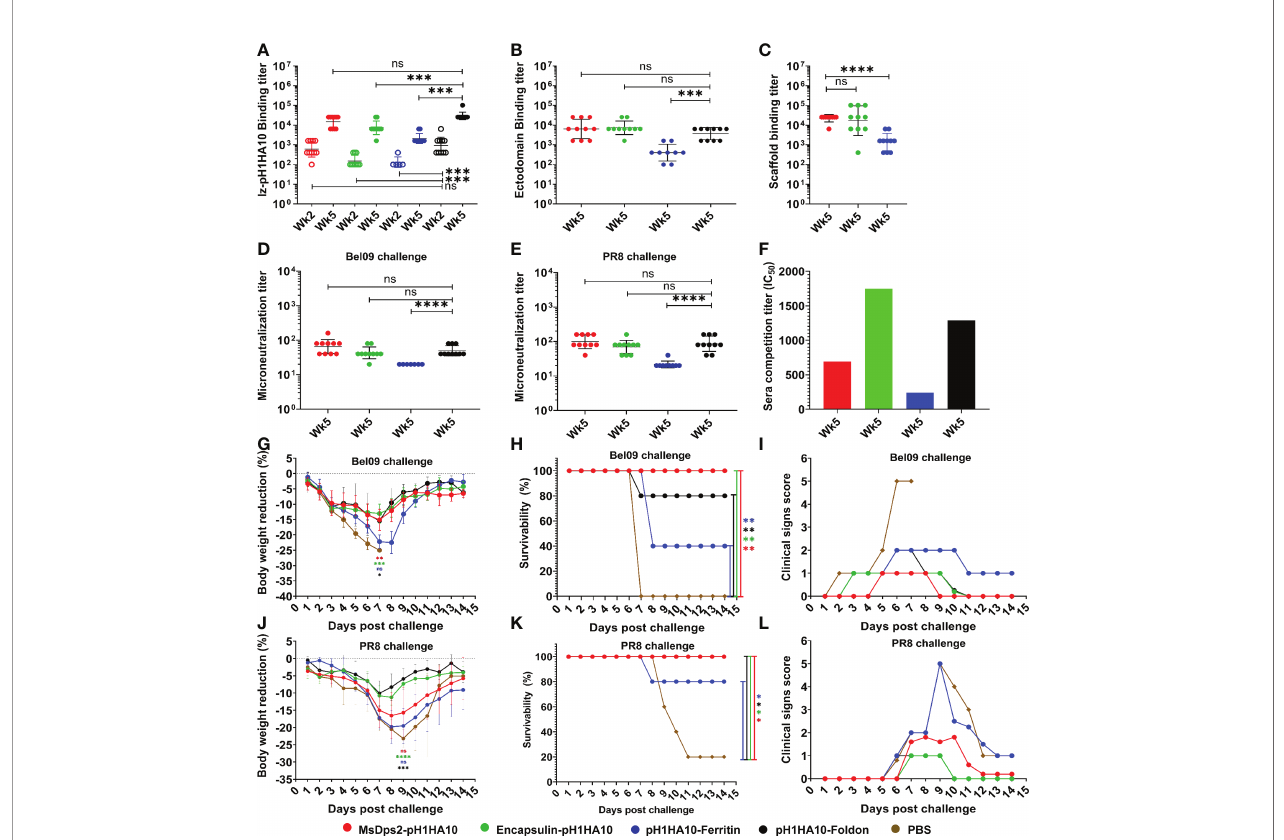
FIGURE 5 | Mice immunization and challenge studies. Mice (n=5) were intramuscularly immunized with stem-nanoparticle immunogens- MsDps2-pH1HA10, Encapsulin- pH1HA10 and pH1HA10-Ferritin on days 0 and 21 with 20µg of SWE adjuvanted antigen. SWE adjuvanted pH1HA10-Foldon and PBS immunized groups acted as trimeric antigen vaccinated and unvaccinated controls, respectively. Sera was collected at days 14 (week 2) and 35 (week 5) and examined for binding titers against (A) pH1HA10-Iz and (B) Ectodomain (Ectodomain binding titers at week 5 are shown). Scaffold titers at week 5 are shown in (C) . Comparison of ELISA binding titer between the pH1HA10-Foldon immunized and nanoparticle displayed pH1HA10 immunized groups was done using two-tailed Mann-Whitney t test. (ns indicates not signi fi cant, * indicates p < 0.05, ** indicates p < 0.01, and **** indicates p < 0.0001). Microneutralization titers were evaluated at week 5 to assess neutralizing antibodies against (D) Bel09 and (E) PR8. Groups were compared using two-tailed Mann Whitney t test (ns indicates not signi fi cant, * indicates p < 0.05, ** indicates p < 0.01, and **** indicates p < 0.0001). (F) Competition assay of pooled sera of each antigen with CR6261 for binding to immobilized pH1HA10-Foldon through SPR. Post immunization, mice were challenged with either 10423 pfu (10MLD 50 ) of vaccine matched, H1N1 A/Belgium/145-MA/2009 (Bel09) virus (G, H) , or 270 pfu (10MLD 50 ) of vaccine mismatched, H1N1 A/Puerto Rico/8/1934 (PR8) strain (J, K) . Mice morbidity (G, J) and mortality (H, K) was monitored up to 2 weeks post challenge. Survivability between vaccinated and unvaccinated groups was compared using a two-way ANOVA test with Bonferroni correction [p < 0.01 (*), p < 0.001 (**), p < 0.0001 (****)]. Multiple T test with Bonferroni Dunn correction was used to compare body weight reduction between groups [p < 0.01 (*), p < 0.001 (**), p < 0.0001 (****)]. (F, I) Individual group averaged clinical scores are shown after (I) Bel09 or (L) PR8 challenge. *** indicates